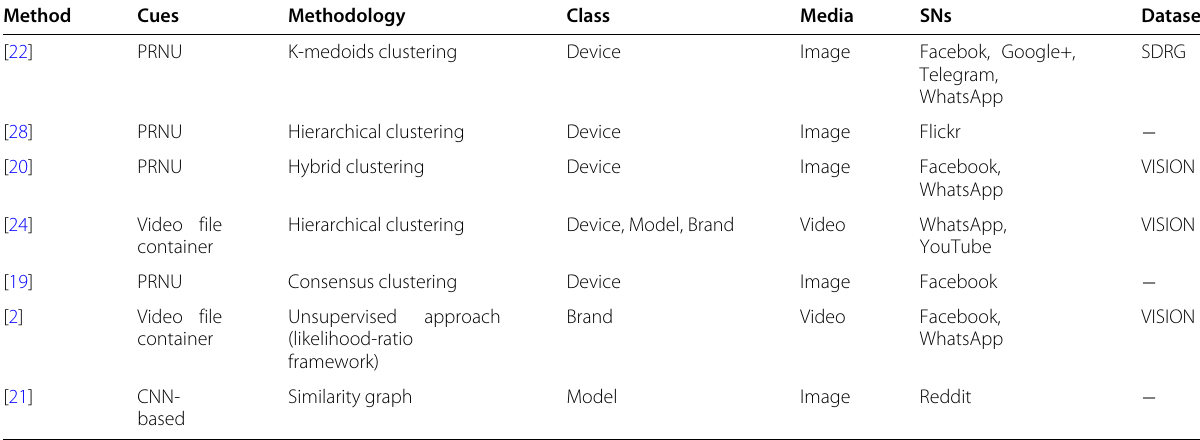
Table 3 Summary of the limited and zero knowledge source identification approaches